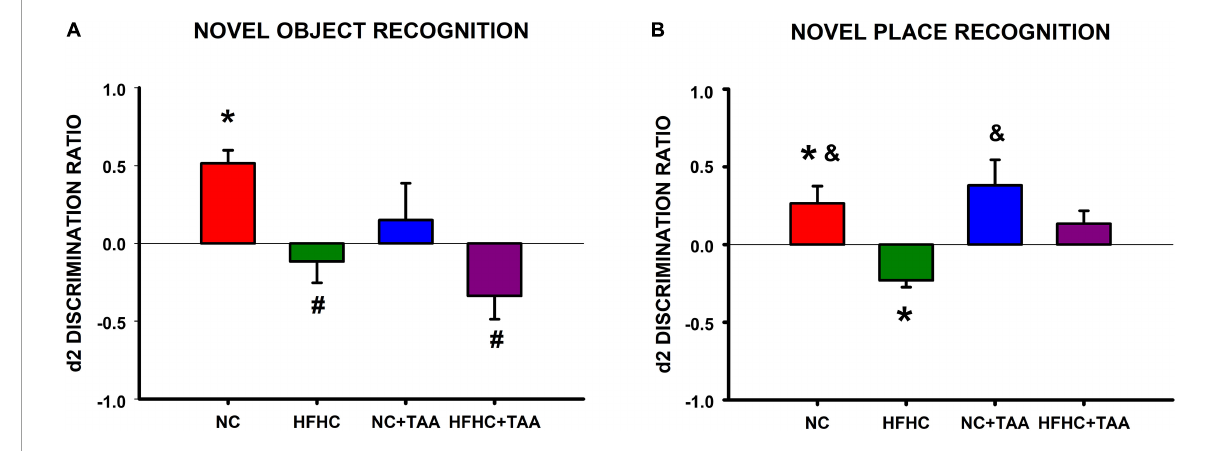
FIGURE11 Object recognition test. (A) Novel object recognition test. Bars charts (mean ± SEM) represent the discrimination ratio (d2) between the new object and the one previously observed. This value was analyzed through a t -test for independent samples (*comparison with zero) and a one-way ANOVA followed by Tukey’s test ( # comparison with NC d2 value; & comparison with HFHC d2 value; * #& p < 0.05). NC was able to discriminate against the new object, whereas HFHC, NC + TAA, and HFHC + TAA were not able to discriminate against it. HFHC and HFHC + TAA displayed a lower d2 ratio than NC; NC + TAA did not show differences from the NC group but an impairment in novel object recognition was found. (B) Novel place recognition test. Bars charts (mean ± SEM) represent the discrimination ratio (d2) between the new location and the one previously used. This value was analyzed through a t -test for independent samples (* comparison with zero) and a one-way ANOVA followed by Tukey’s test (# comparison with NC d2 value; & comparison with HFHC d2 value; * #& p < 0.05). NC showed a preference for the new location, whereas NC + TAA and HFHC + TAA were not able to discriminate the new place of the object. Moreover, HFHC spent more time exploring the object in the previous location and it displayed a lower d2 ratio than NC and NC +